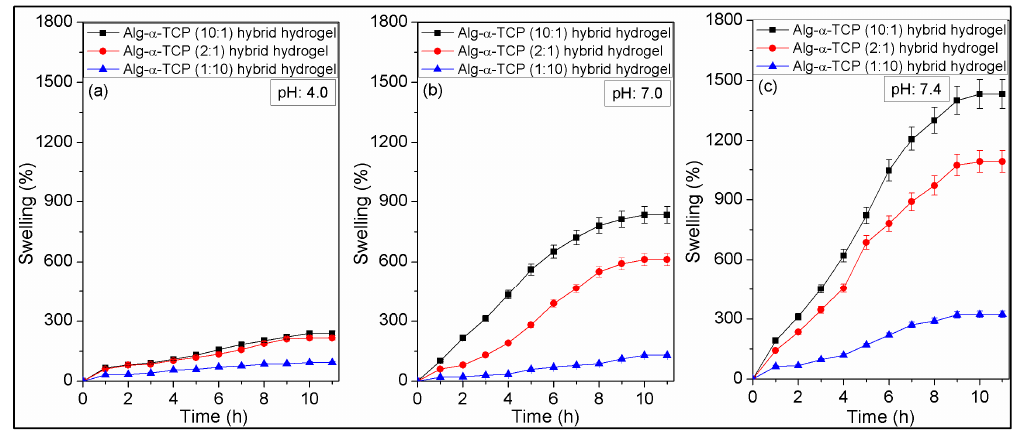
Figure 6. Swelling behaviors of Alg- α -TCP (10:1, 2:1 and 1:10) hybrid gels at ( a ) pH 4.0; ( b ) pH 7.0; ( c ) pH 7.4 and 37 °C.